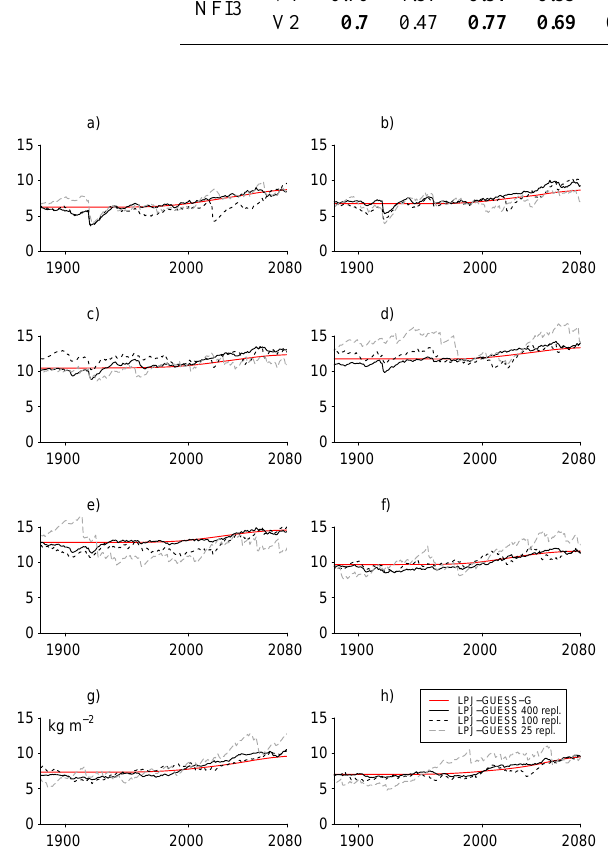
Fig. 4. Tree carbon mass development. Tree carbon mass from spinup time (before 1900) until 2080 with the new GAPPARD method applied to LPJ-GUESS (LPJ-GUESS-G) and for LPJ-GUESS using 400, 100 and 25 replicate patches.